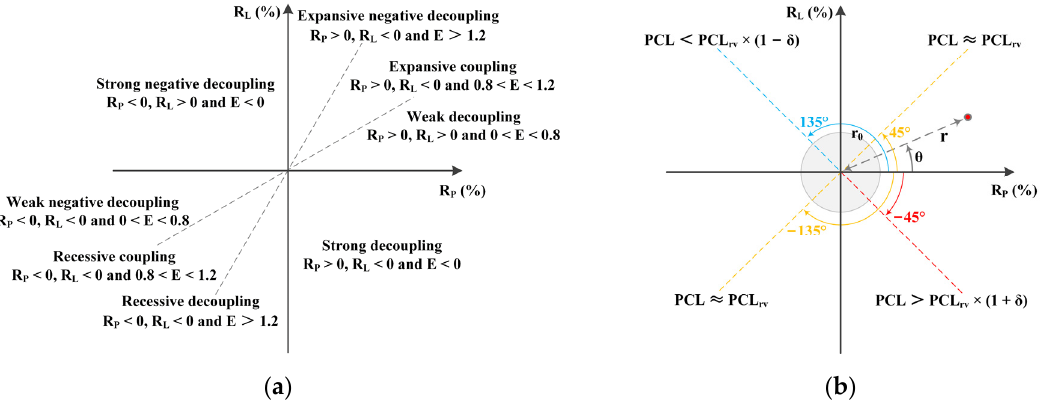
Figure 2. Tapio’s decoupling model of elasticity and the coupling model of polar coordinates proposed in this study: ( a ) Tapio’s decoupling model of elasticity. In the figure, R L and R P are the change rates of construction land and population, respectively, and E is the population elasticity of construction land. ( b ) Coupling model of polar coordinates. In the figure, PCL and PCL rv are the per-capita construction land area and its ideal value, respectively, and δ is the tolerance coefficient of PL.